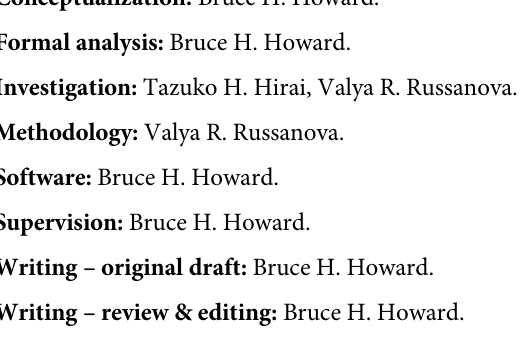
S3 Fig. LMNA-associated PcG region: Monocyte vs. dendritic cell (DC) profiles. A. Esti- mated region boundaries for a large (approx. 50 kb) H3K27me3-enriched domain overlapping the LMNA promoter region in monocyte samples. Blue bar and arrow depict LMNA tran- scribed region; white rectangle represents region boundaries derived from monocyte data. B. LMNA monocyte and DC expression (red points, log counts per million) relative to all quanti- fied loci (box-whisker plots). Panels CD represent coverage profile comparisons for this region, with differences highlighted in blue. (PDF) S4 Fig. Mean- vs. eigenvector-derived correlation estimates. Sample of 2000 regions (length 2–4 kb) satisfying enrichment and composite thresholds as described in Methods. meanCE, correlation estimate based on mean of matrix off-main diagonal pairwise values. eigenCE, cor- relation estimate based on ratio of the first eigenvalue to the trace of the matrix. (PDF) S5 Fig. IGF1R H3K27me3 regions. PcG (H3K27me3) region spans for monocytes (Mo) and dendritic cells (DC) obtained from cord blood (Cb), young adult (Yo) or old adult (Ol) sam- ples. Blue bar and arrow depict IGF1R transcribed region; white rectangle represents region boundaries derived from adult (Yo and Ol) data.